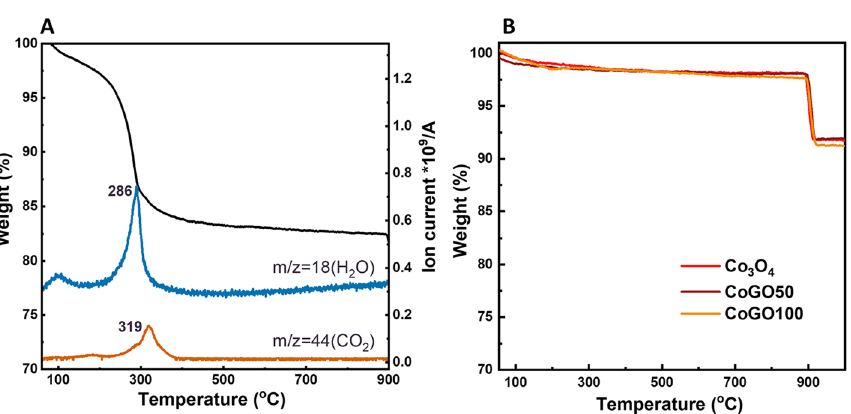
Figure 3. ( A ) TG-mass profiles of CoGO50 precursor in air (H 2 O signal m/z = 18 and CO 2 signal m/z = 44) and ( B ) TG curves of Co 3 O 4 , CoGO50 and CoGO100 in